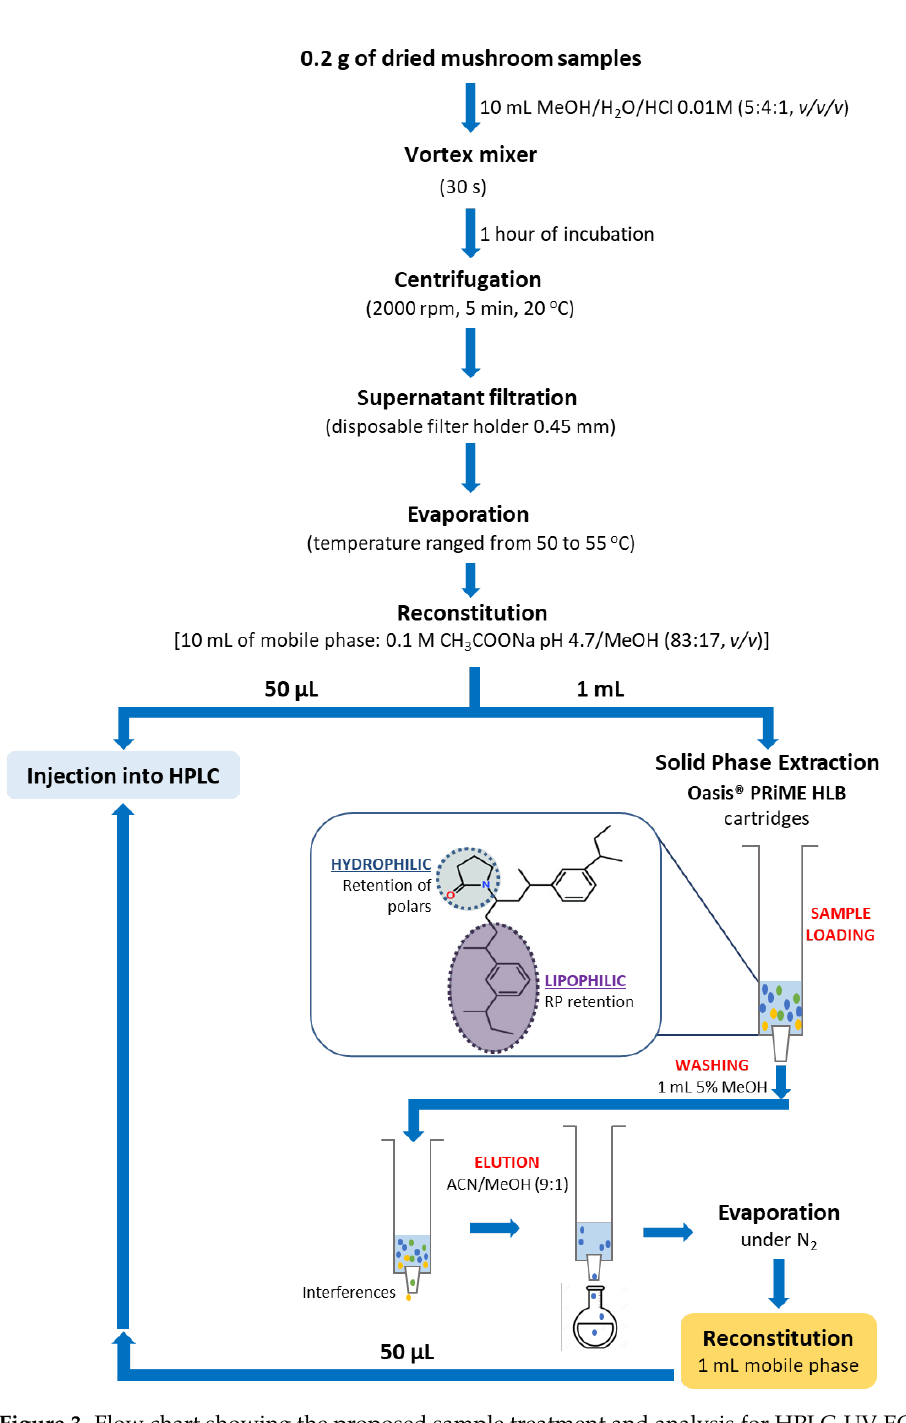
Figure 3. Flow chart showing the proposed sample treatment and analysis for HPLC – UV – EC.